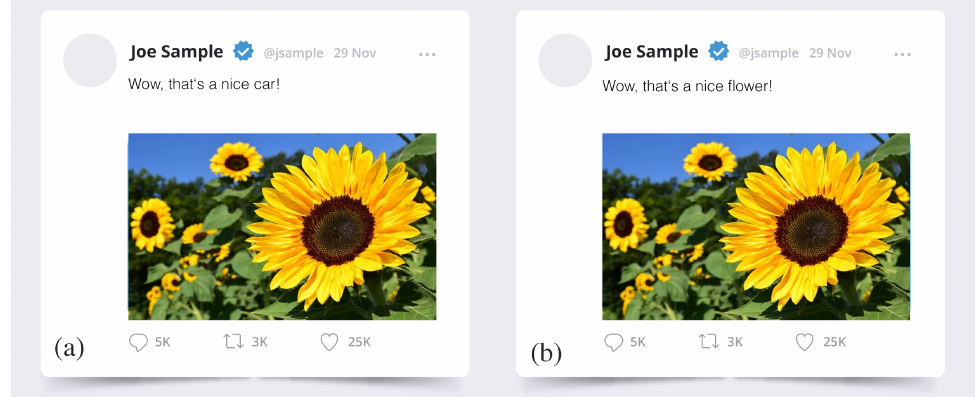
Figure 5. Exemplary social media post with information, that is not sound ( a ) and sound ( b